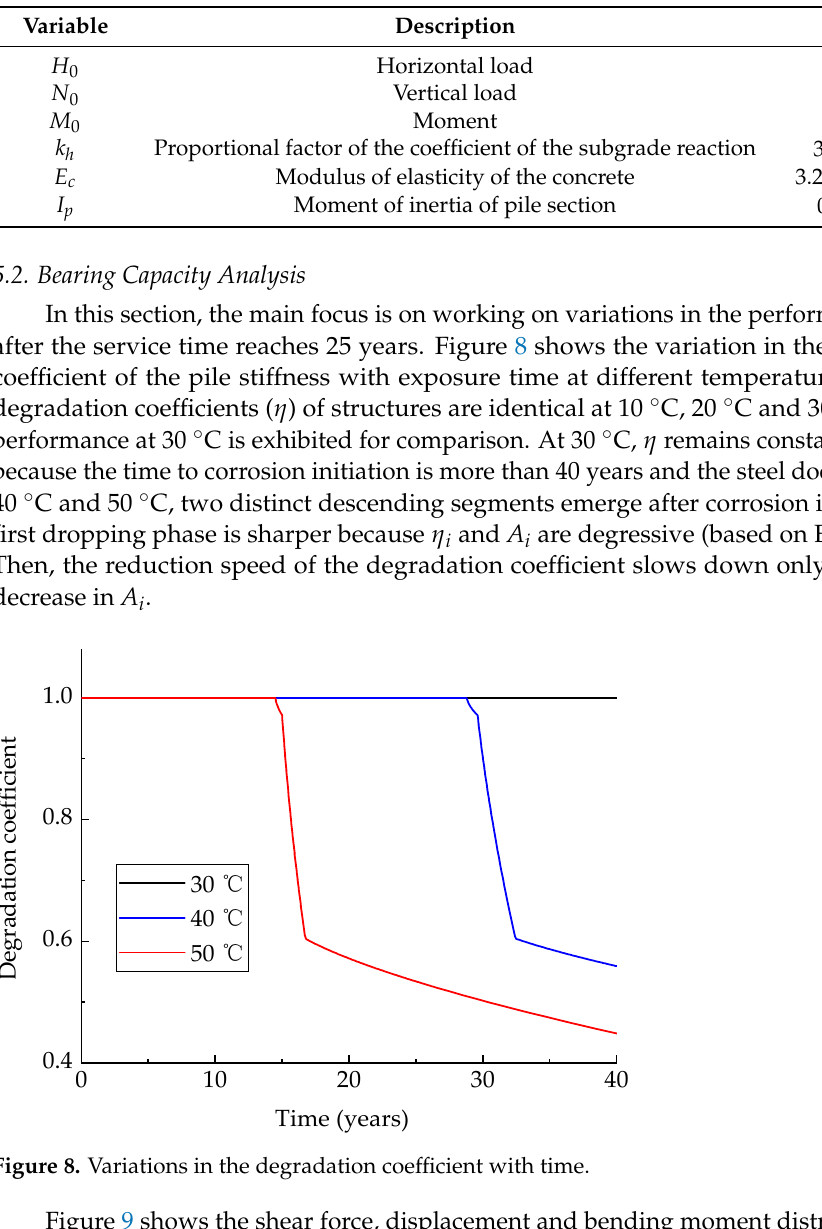
Table 5. Initial stress state and basic characteristics of piles.